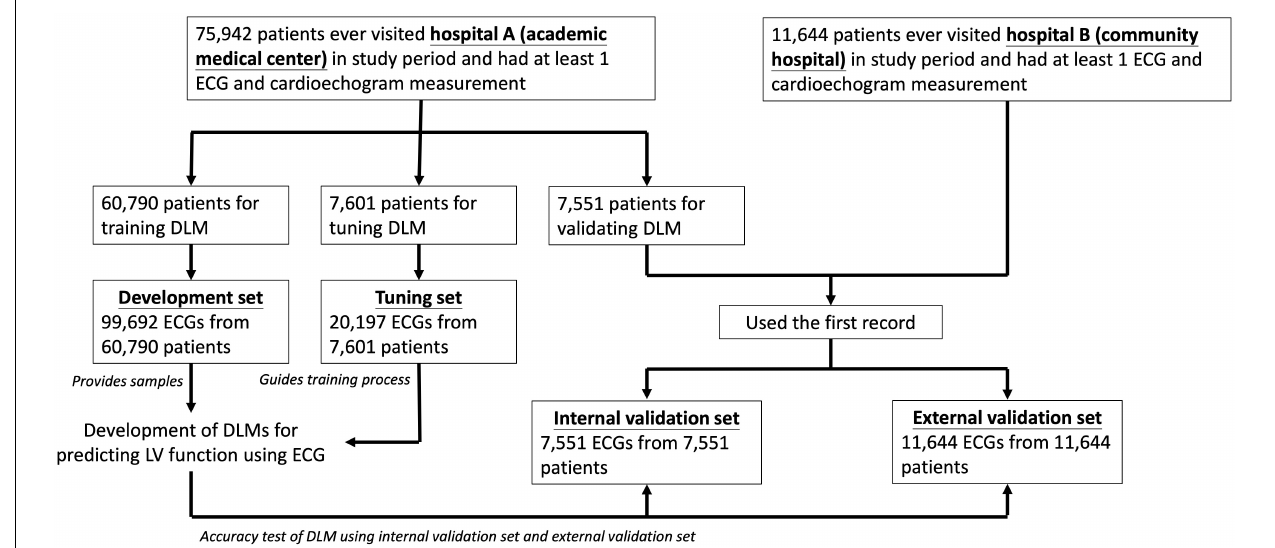
FIGURE 1 | Development, tuning, internal validation, and external validation sets generation and the ECG labeling of echocardiogram. Schematic of the dataset creation and analysis strategy, which was devised to assure a robust and reliable dataset for training, validating, and testing of the network. Once a patient’s data were placed in one of the datasets, that individual’s data were used only in that set, avoiding “cross-contamination” among the training, validation, and test datasets. The details of the flowchart and how each of the datasets was used are described in “Materials and Methods” section.